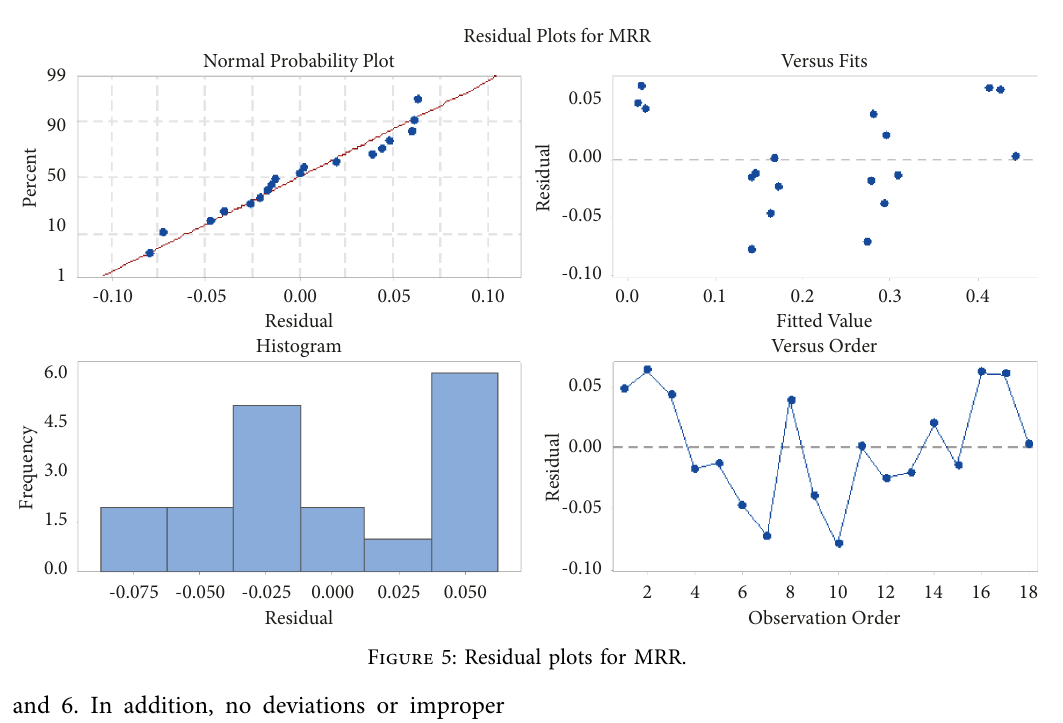
Figure 5: Residual plots for